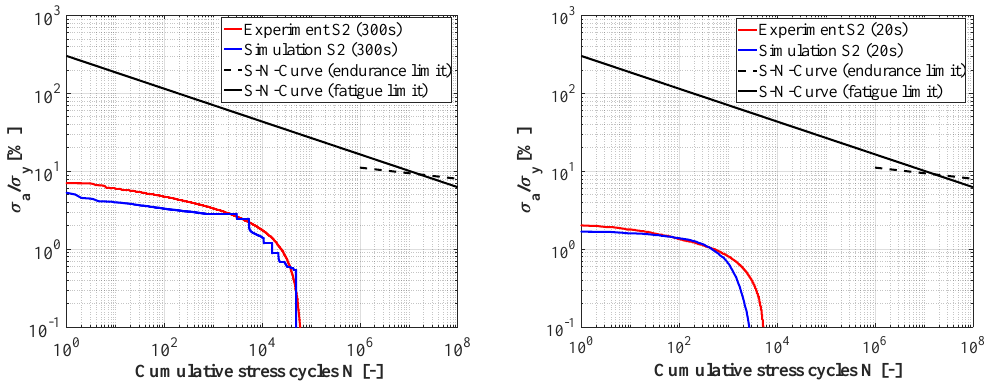
Figure 10. Load spectra of the measured and computed stresses for ( a ) the unsteady case at 44% · P